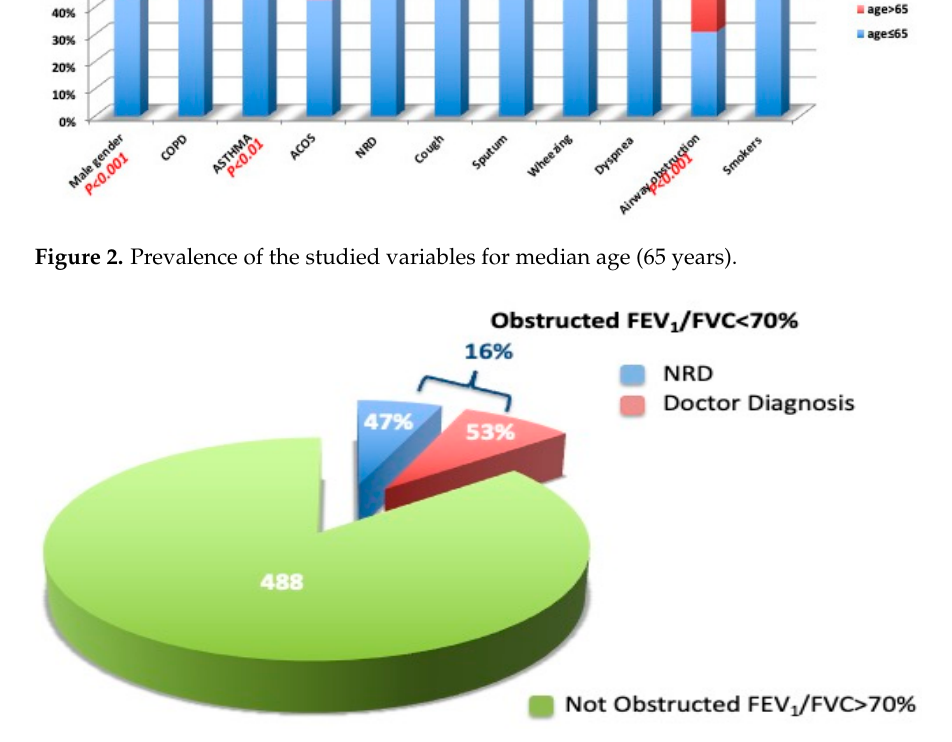
Figure 3. Airflow obstruction prevalence in the overall sample.